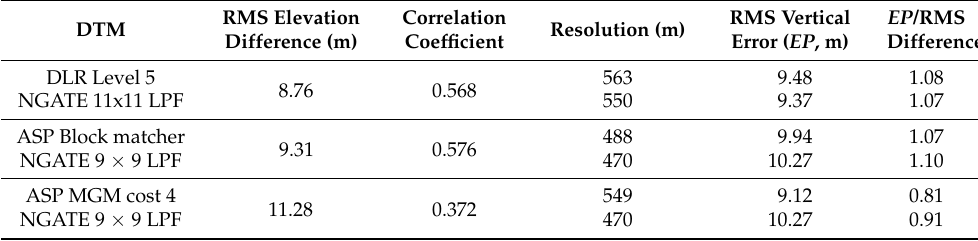
Table 4. Differences between overlapping target DTMs compared to vertical precision EP